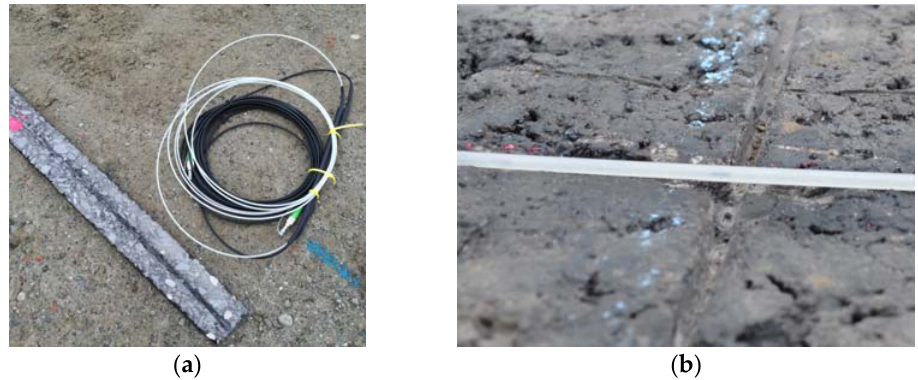
Figure 2. Installation of FBGs in prefabricated asphalt in the base layer ( a ) and installation of FBGs in the previously constructed asphalt layer ( b ).